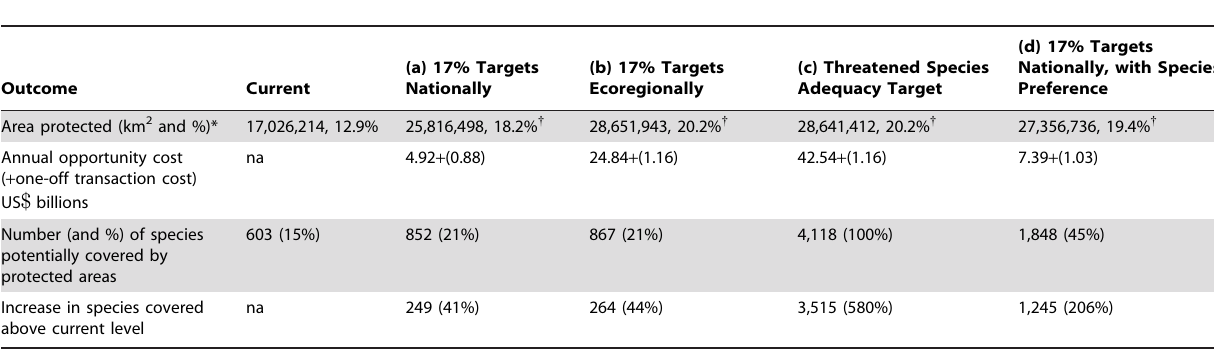
Table 1. Costs and benefits of the current protected area network and for future protection scenarios that (a) meet country-level targets for protected area coverage; (b) meet these targets while also achieving 17% protection of each terrestrial ecoregion; (c) meet the targets from scenario a and protect a scaled fraction of the geographic ranges of threatened terrestrial birds, mammals, and amphibians; and (d) achieve the country-level targets for protected area coverage while also achieving five times the level of biodiversity protection relative to scenario a.